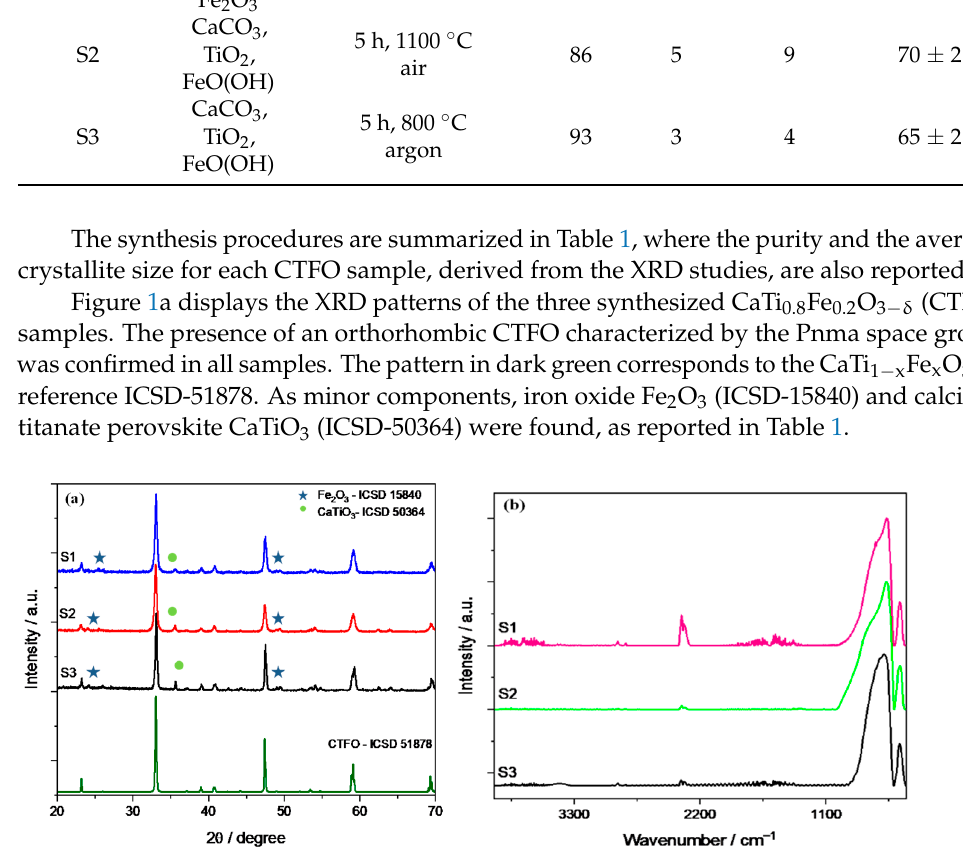
Figure 1. ( a ) X-ray diffraction pattern and ( b ) infrared spectra of the synthesized CTFO